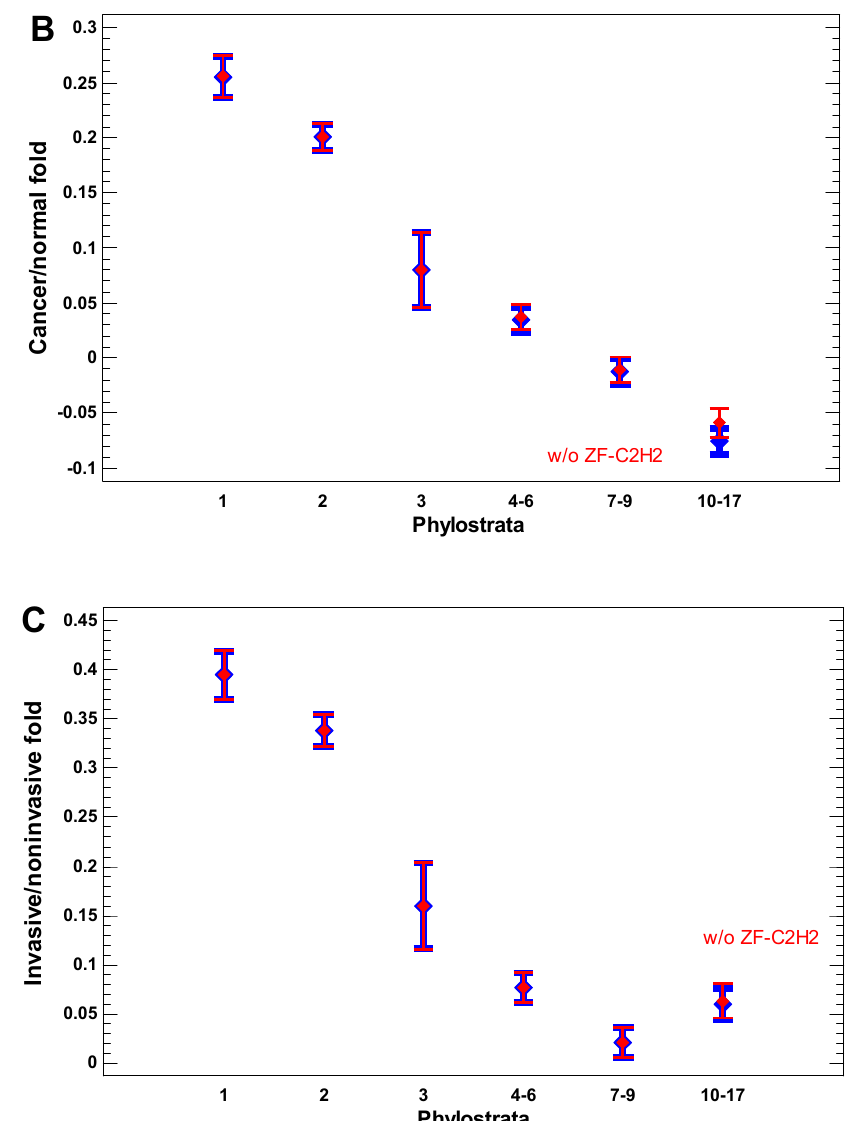
Figure 4. The evolutionary profile of gene expression folds: ( A ) cancer/normal fold in the ‘breast cancer’ dataset; ( B ) cancer/normal fold in the ‘melanoma’ dataset; ( C ) invasive/non-invasive fold in the ‘myeloma’ dataset. Because the detailed picture for all 17 phylostrata is noisy, the folds for consecutive phylostrata were averaged, roughly in accordance with the expression levels in Figure 3. The data without ZF-C2H2 genes are shown in red. The moderate activation of ZF-C2H2 genes in breast cancer cells can be seen ( A ). Phylostrata: 1—cellular organisms (Prokaryota); 2—Eukaryota;